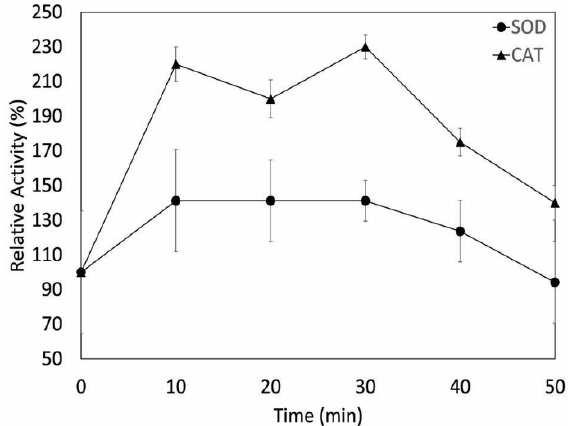
Figure 3. Effect of UV-C radiation on superoxide dismutase (SOD) and catalase (CAT) activities of I1P. Cells were exposed to UV-C radiation for 50 min. SOD and CAT activities were measured at different lengths of time and compared to the enzyme activities of the unexposed cells (time 0), which were assigned 100% of the relative activity. Measurements were performed in triplicate.